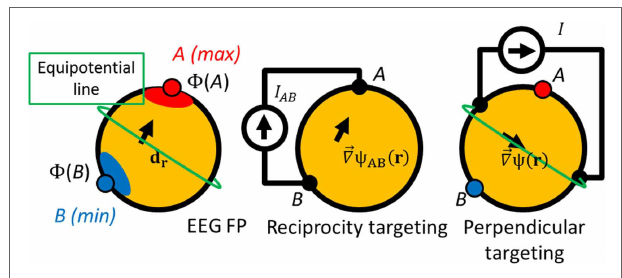
FIGURE 3 | Schematics of the reciprocity targeting. Left: a simulated dipole at position r with moment d r generates a potential distribution Φ with a maximum (point A), a minimum (point B), and a isopotential lines (like the green one). Center: poles A and B can be used for the current injection maximizing the component of the gradient of the potential ⃗ r ψ AB in the direction d r . Right: if any injection pair is on an isopotential line [ Φ ( A ) (cid:0) Φ ( B ) = 0], the current density on target is perpendicular to the target